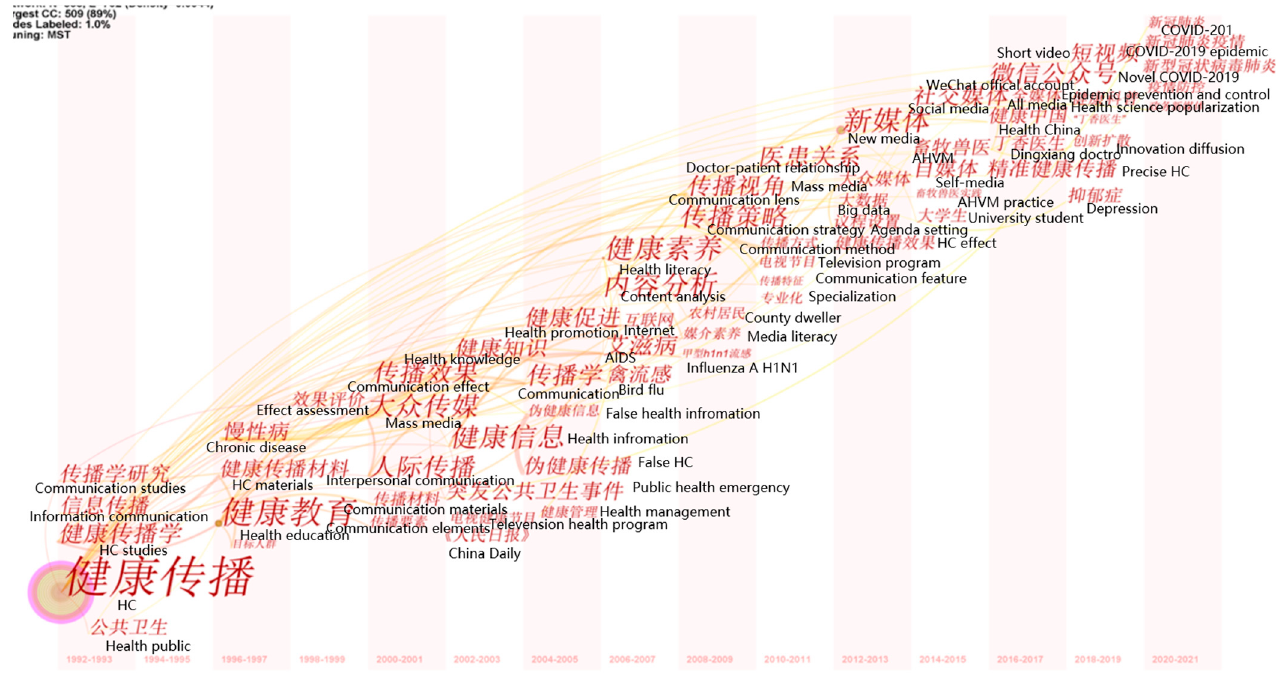
Figure 6. The time-zone map of HC research in China between 1992 and 2021. (Note: the authors added English to the map to aid understanding).